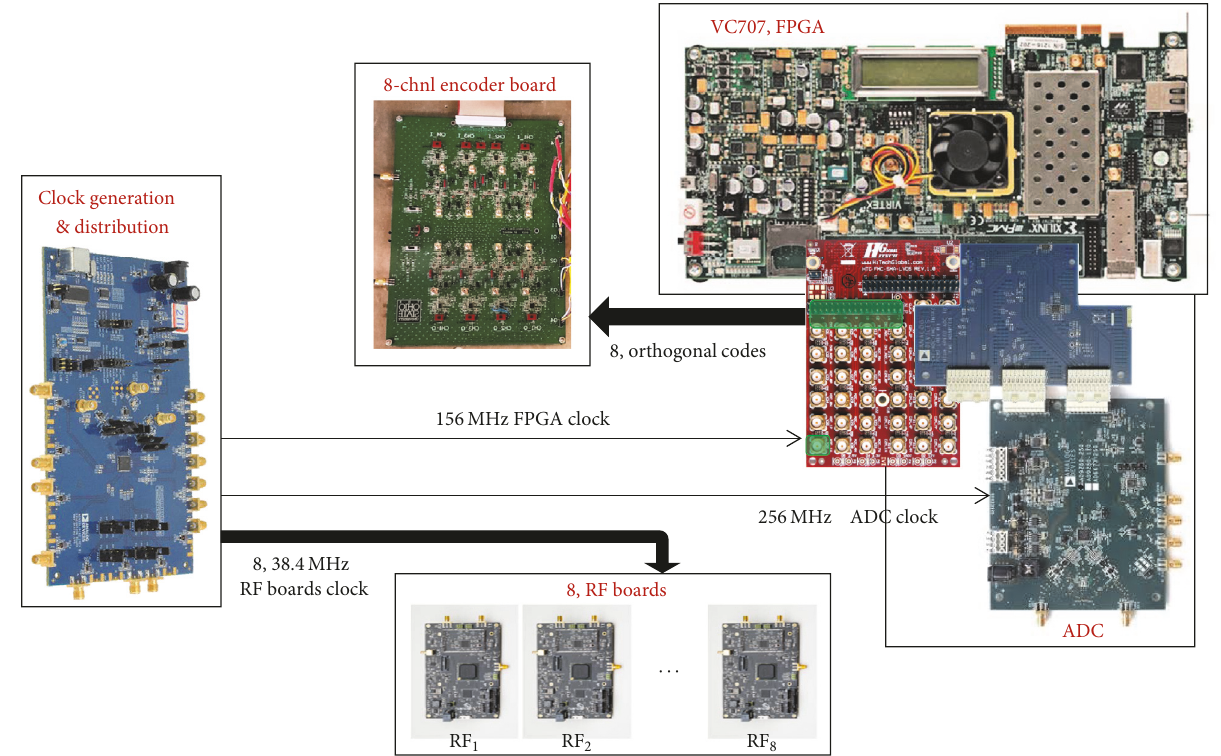
Figure 6: Clock generation and synchronization requirement for an 8-channel OSCR using external